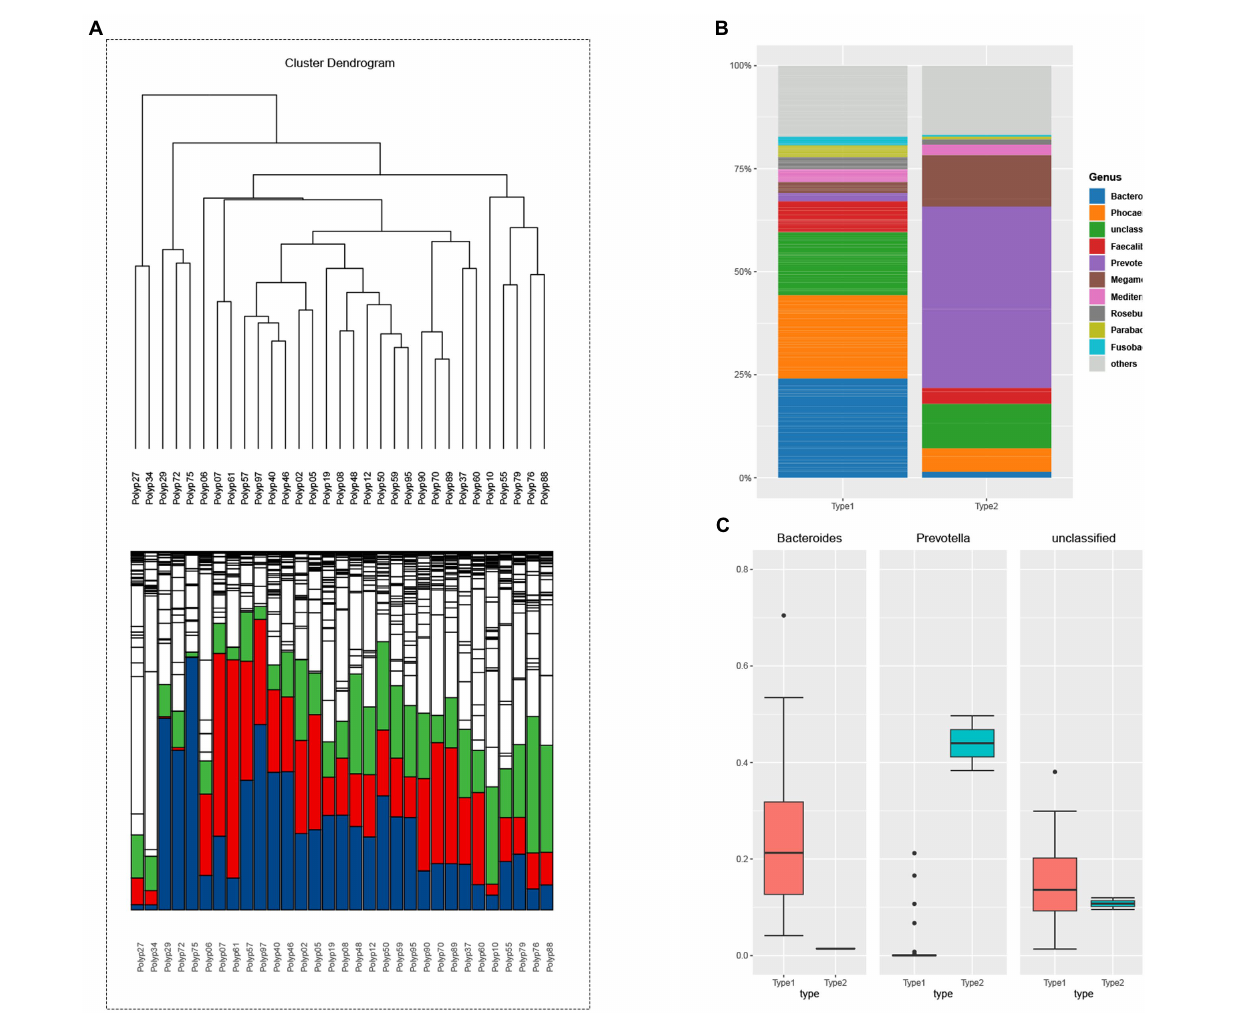
FIGURE 2 (A) The hierarchical clustering result of adenoma group. The clustering results reflect the distance between the samples, allowing the samples to be divided into two distinct enterotypes and showing the relative abundance of the bacteria contained in the sample at the level of the genus contained in each branch. Enterotype- Bacteroides : 10; Enterotype- Prevotella : 49. (blue: Bacteroides ; green: Prevotella , red: Faecalibacterium ). (B) The samples were divided into two groups according to the clustering results of adenoma group, and the top 10 genera contained in each group were displayed. Bacterial community of two enterotypes: a bacterial proportion in the two enterotypes. (C) The grouping box diagram shows the percentage content of the three bacterial genera in the three groups clustered by samples in adenoma group.